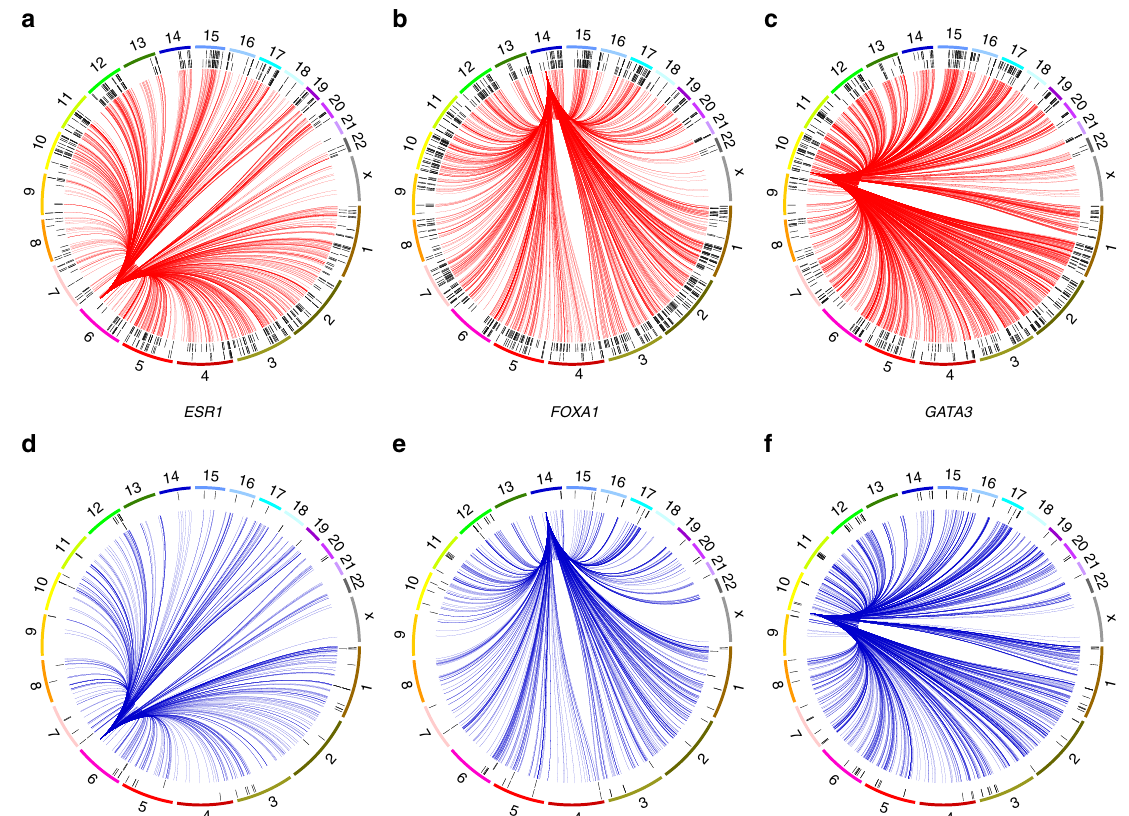
Fig. 7 Circos plots showing the genomic location of all CpGs in emQTL with ESR1 , FOXA1 and GATA3 . Circos plot representing all associations between CpGs and ESR1 ( a , d ), FOXA1 ( b , e ), and GATA3 ( c , f ). Red lines represent negative associations a – c and blue lines represent positive correlations d – f . The outer ring indicates whether a CpGs is located in an enhancer determined by MCF7 ChromHMM annotation and the inner ring whether it is located in a binding region of the respective TF determined by ChIP-seq